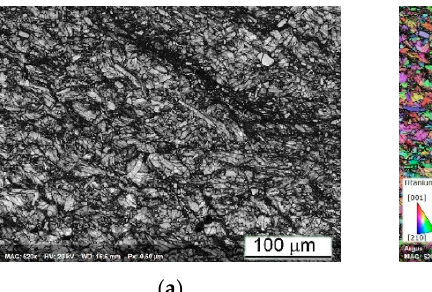
Figure 17. SEM BSE images of Ti64 + 10TiB after the SHPB tests with strain rates ( a , b )—1280 s − 1 , ( c , d )—2510 s − 1 . ( a , c )—Zone II; ( b , d )—Zone I.